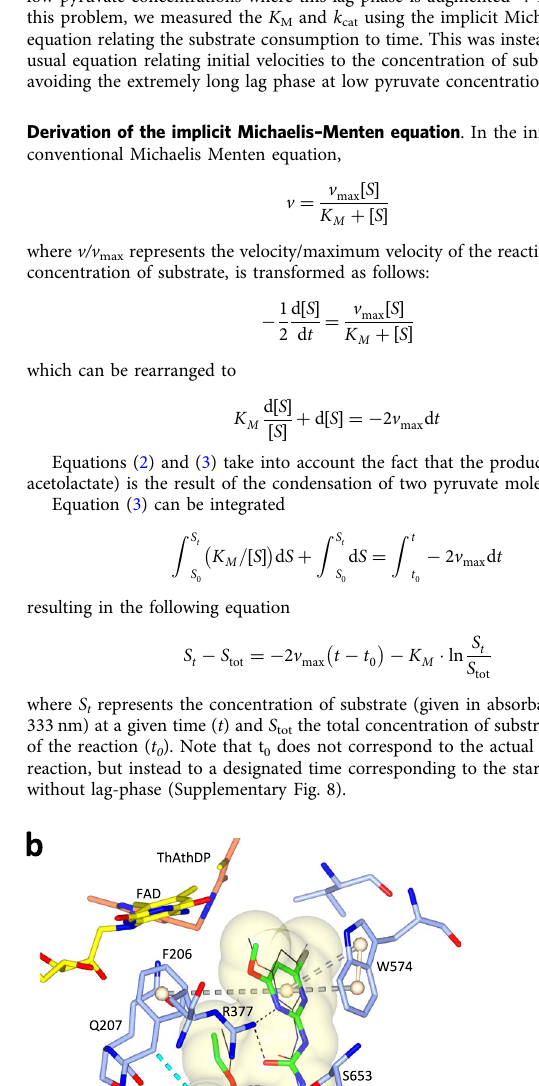
Supplementary Table 6. The parental plasmid was then digested with Dpn I restriction enzyme and the resulting mutant At AHAS containing constructs transformed into E. coli DH5 α chemically competent cells. The correct introduc- tion of each mutation was con fi rmed by Sanger sequencing at the Australian Genome Research Facility. For the expression and puri fi cation of WT and mutant At AHAS followed a previous protocol, but with some modi fi cations 13,30 . The procedure applied here was to start with E. coli BL21 (DE3) transformed cells grown in Terri fi c Broth media at room temperature. When the OD 600 reached 2.0, the expression of the protein was induced by 0.1 mM IPTG at 16°C and 150 opm. The cell culture was then centrifuged at 4 °C, 3300 × g for 20 min, and pellets were collected and stored at − 80°C. For lysis, the pellet was resuspended in an IMAC binding buffer (50 mM Tris,